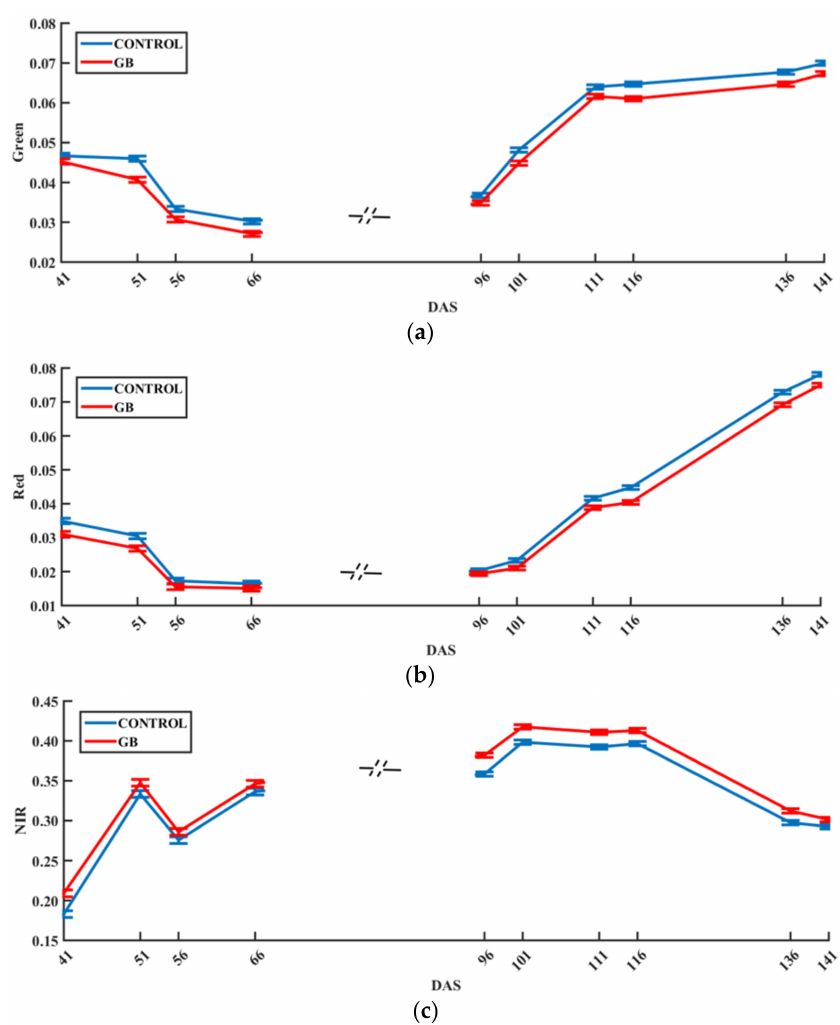
Figure 7. Average surface reflectance values for the green ( a ), red ( b ) and NIR ( c ) bands for each available date before ( left ) and after ( right ) the NDVI peak using Sentinel-2 data (the vertical bars indicate the LSD interval ( p < 0.05) for the separation of